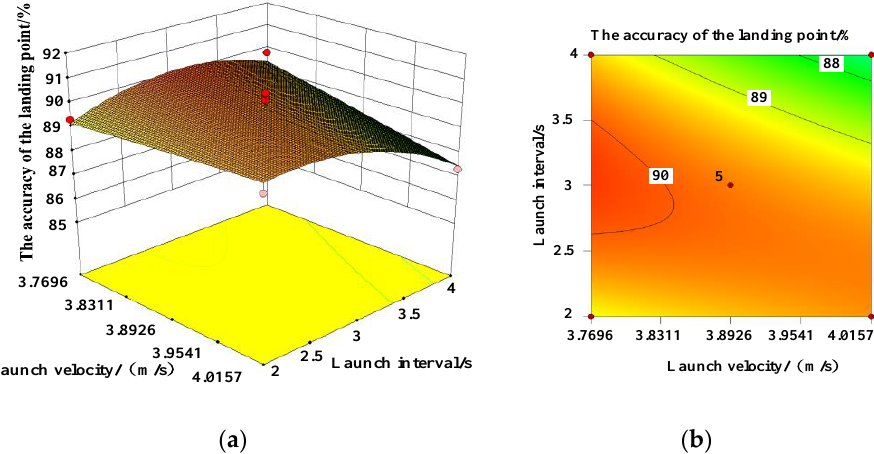
Figure 5. ( a ) Response surface and ( b ) contour plot for the interaction between launch height and launch interval on landing accuracy. ( a ) Response surface; ( b ) contour lines.